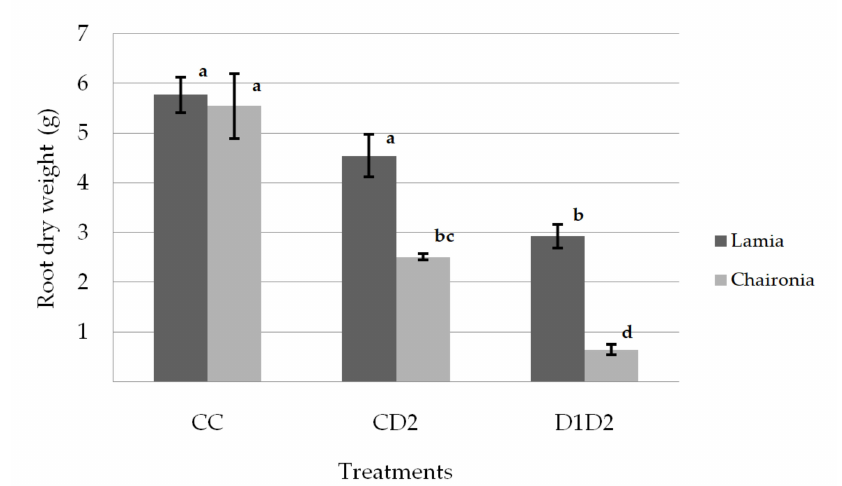
Figure 3. Root dry weight on day 133. Bars show the mean of the biological replicates ± SE; lower case letters indicate significant di ff erences between means ( p <